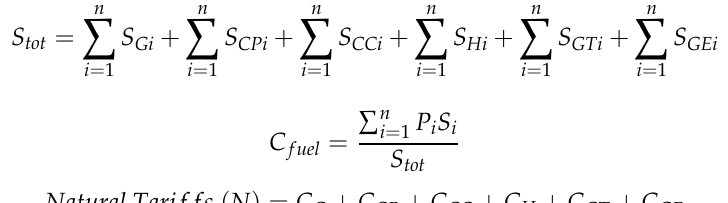
Figure 7. Comparison of the regular, natural, and demand response tariffs.